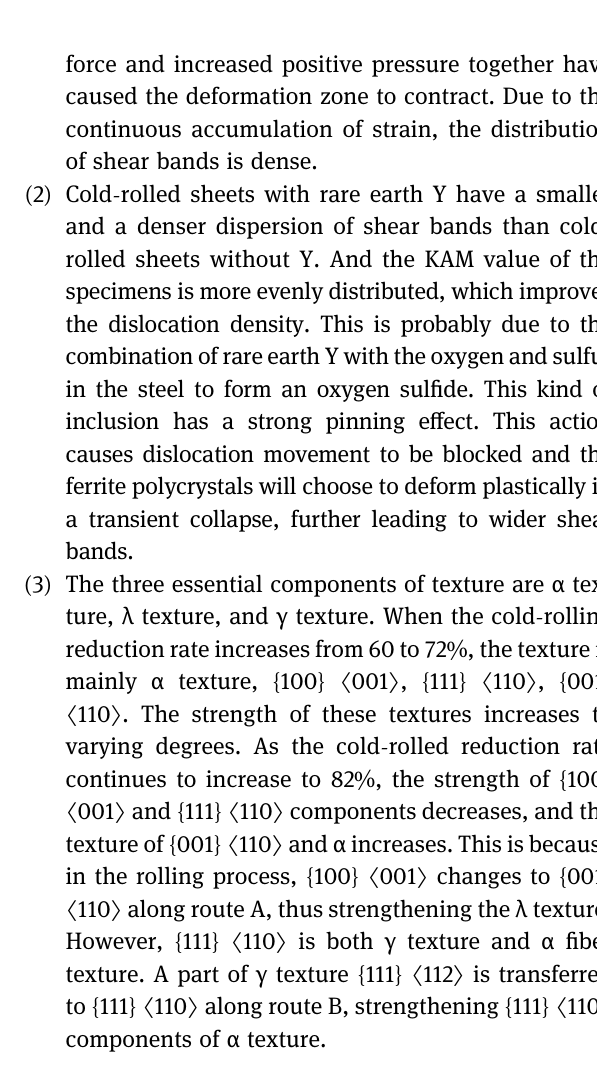
Figure 12: Distribution diagram of α orientation line of two cold - rolled sheets: ( a ) Y - free; ( b ) Y -